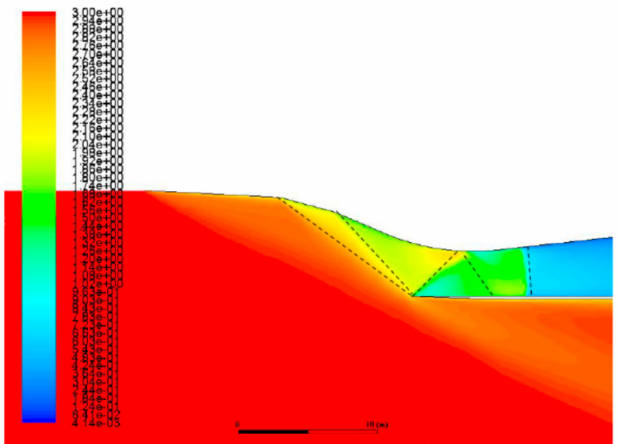
Figure 6. Mach 3.0 Mach